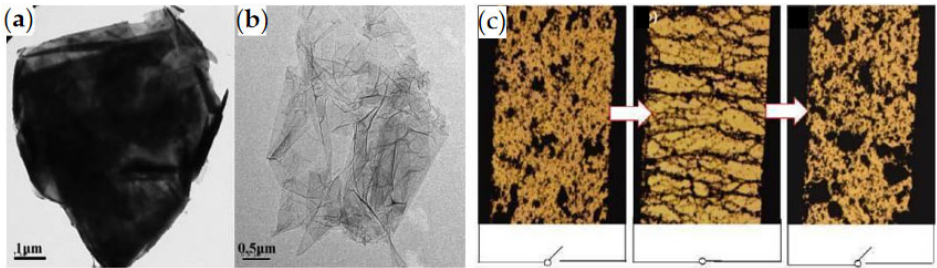
Figure 2. TEM images of graphene ( a ) and GO ( b ) and optical microscope photo of ER effect of GO ER fluids ( c ) [70]. It is seen that the GO particles form fibrous structure when the electric field is applied, while the particles go back to a freely dispersed state when the electric field is removed.